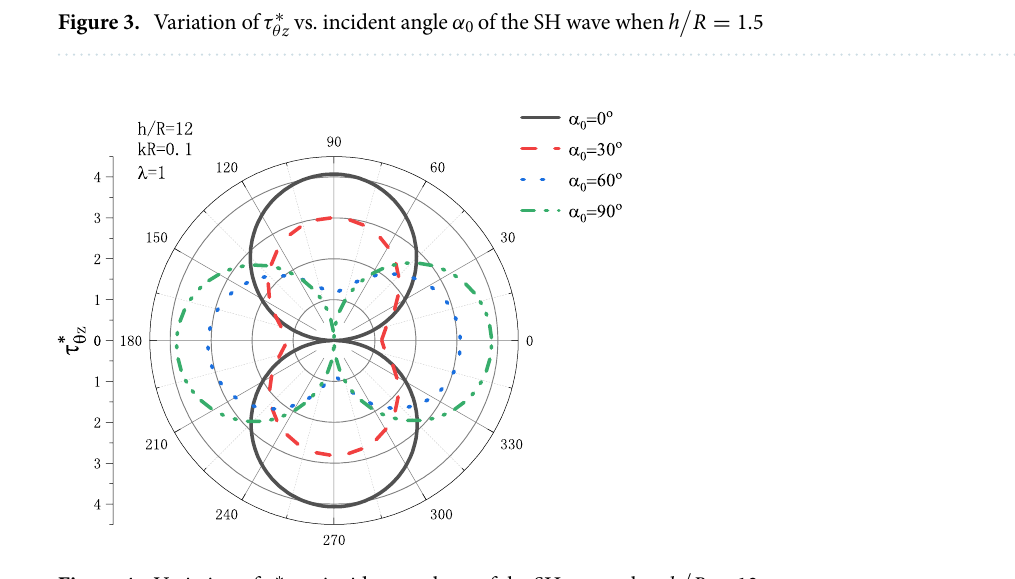
Figure 4. Variation of τ ∗ θ z vs. incident angle α 0 of the SH wave when h